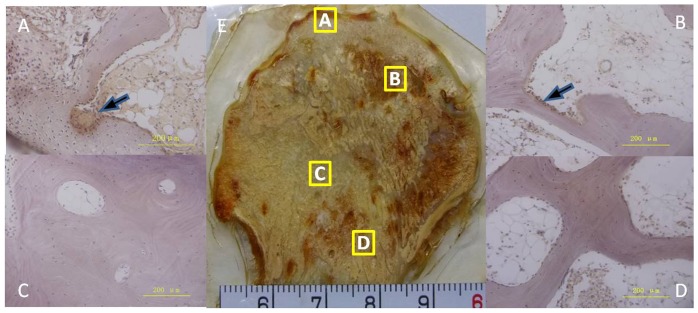
Histology of tartrate-resistant acid phosphatase (TRAP) staining.Black arrows indicated TRAP-positive cells in the subchondral bone (A) and necrotic regions (B). A reduced number of ALP-positive cells was observed in the sclerotic (C) and healthy (D) regions. TRAP staining of an undecalcified bone tissue slice of an entire section (E).